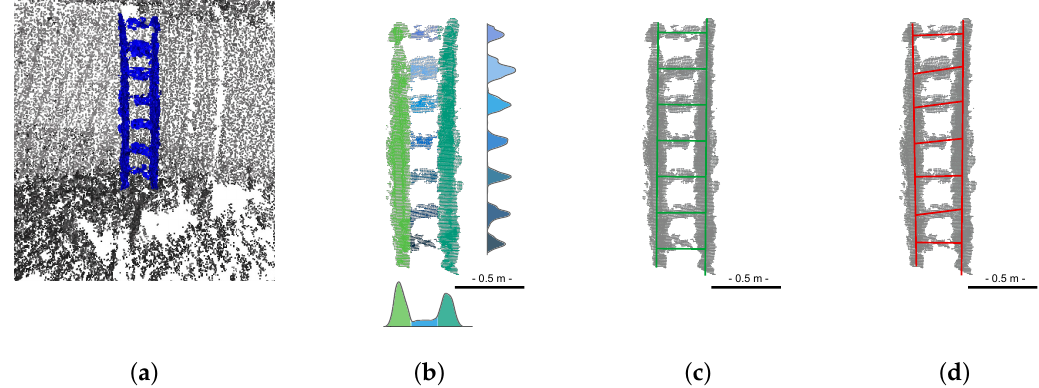
Figure 16. Illustration of the ladder fitting process: Extraction of ladder points from raw data ( a ); Segmentation into separate point clouds ( b ); Robust fitting of ladder using M-estimation and structural priors ( c ); Non-robust fitting using commercial software ( d